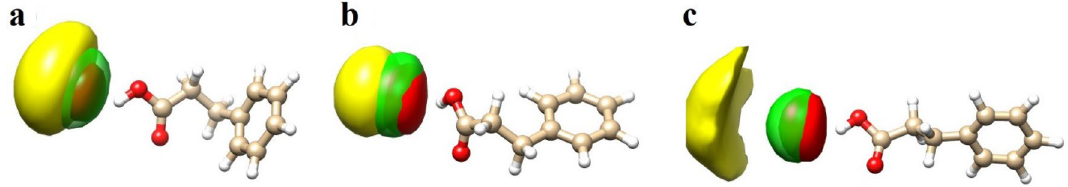
Figure 3. Spatial distribution functions of relevant atoms around phenyl propionic acid in DES at ( a ) 298 K, ( b ) 321 K, ( c ) 400 K and 0.1 MPa were calculated using TRAVIS 61 software: yellow, choline cation; green, chloride anion; red, Phpr molecule. The isodensity used for the SDF corresponding to choline cation, Phpr, and chloride anion are 2, 2, and 4 times bulk density.